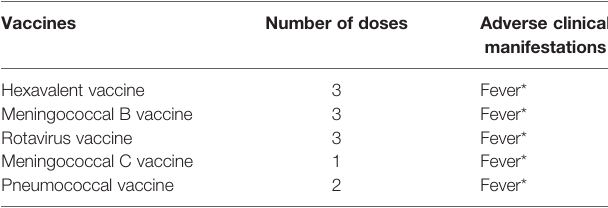
TABLE 1 | Vaccines received by the patient in accordance to the Italian scheduled vaccinations.